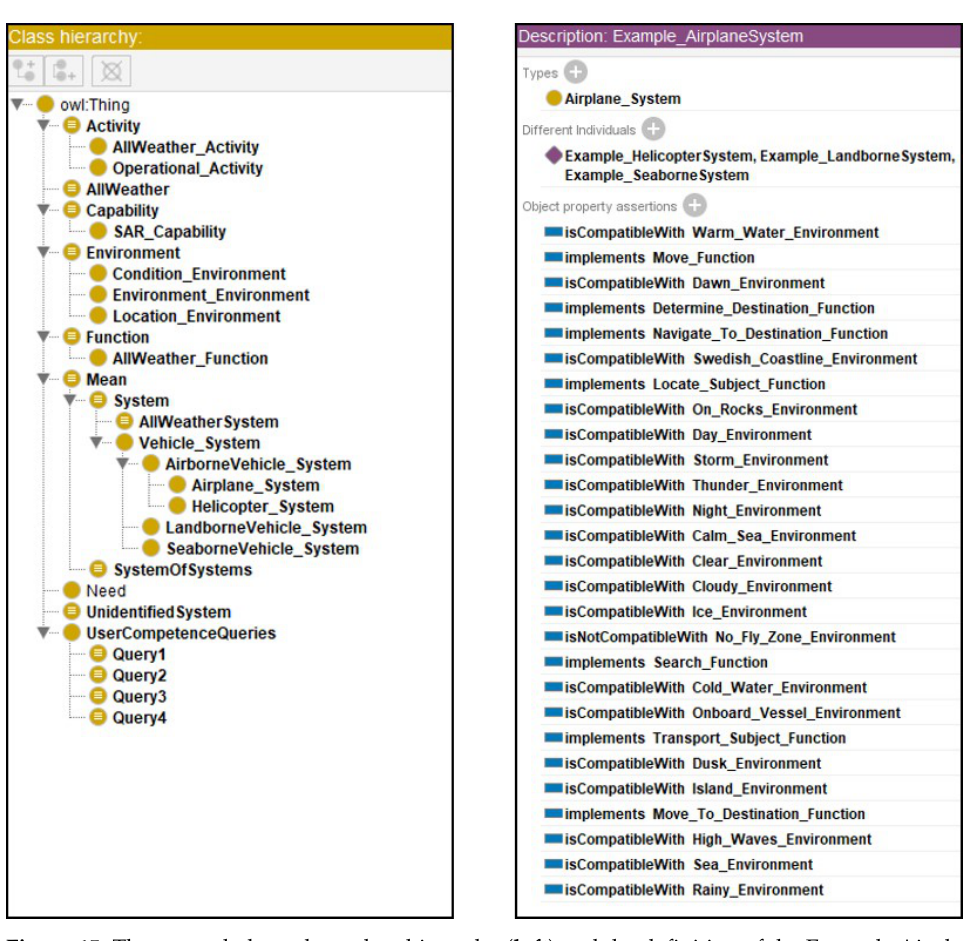
Figure 15. The expanded ontology class hierarchy ( left ) and the definition of the Example Airplane System individual ( right ).